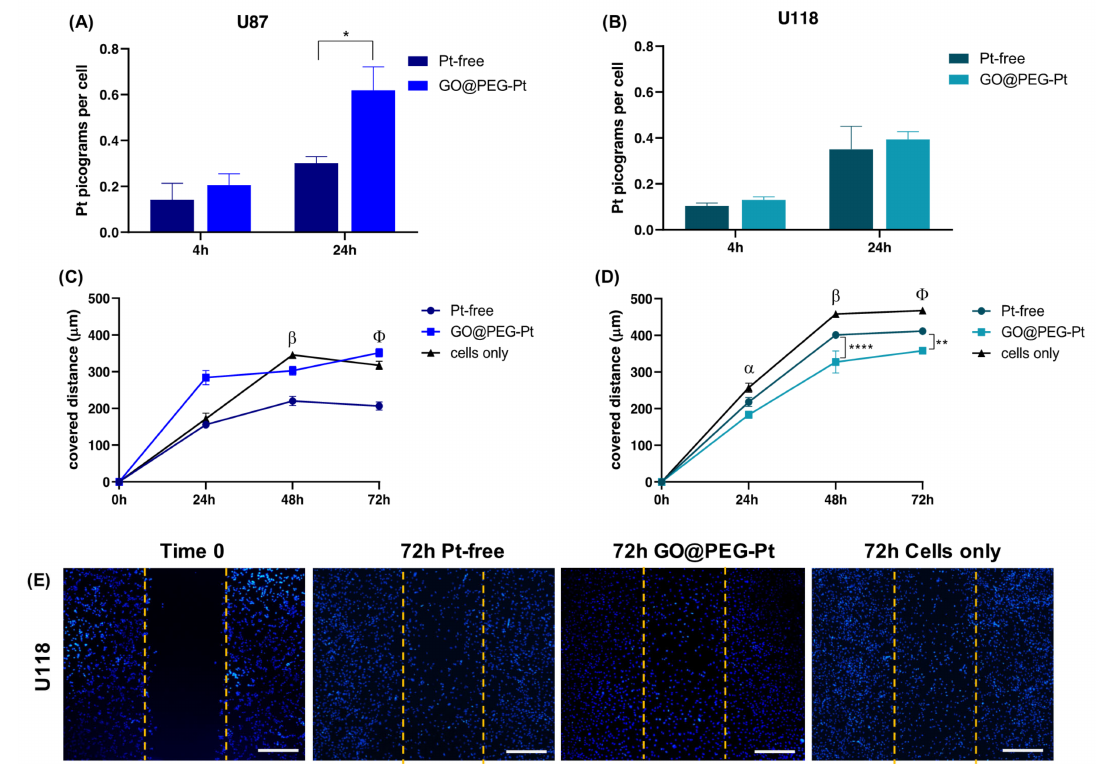
Figure 8. Human glioblastoma cell lines. ICP-OES on U87 ( A ) and U118 ( B ). Scratch test on U87 ( C ) and U118 ( D ); α : Pt-free vs. cells alone, p value ≤ 0.05, and GO@PEG-Pt vs. cells